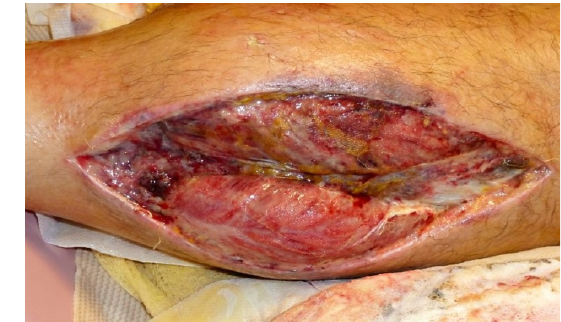
Figure 1. The medial calf wound post-HBOT still shows obvious edema, but appears well perfused and shows no signs of necrosis or infection.